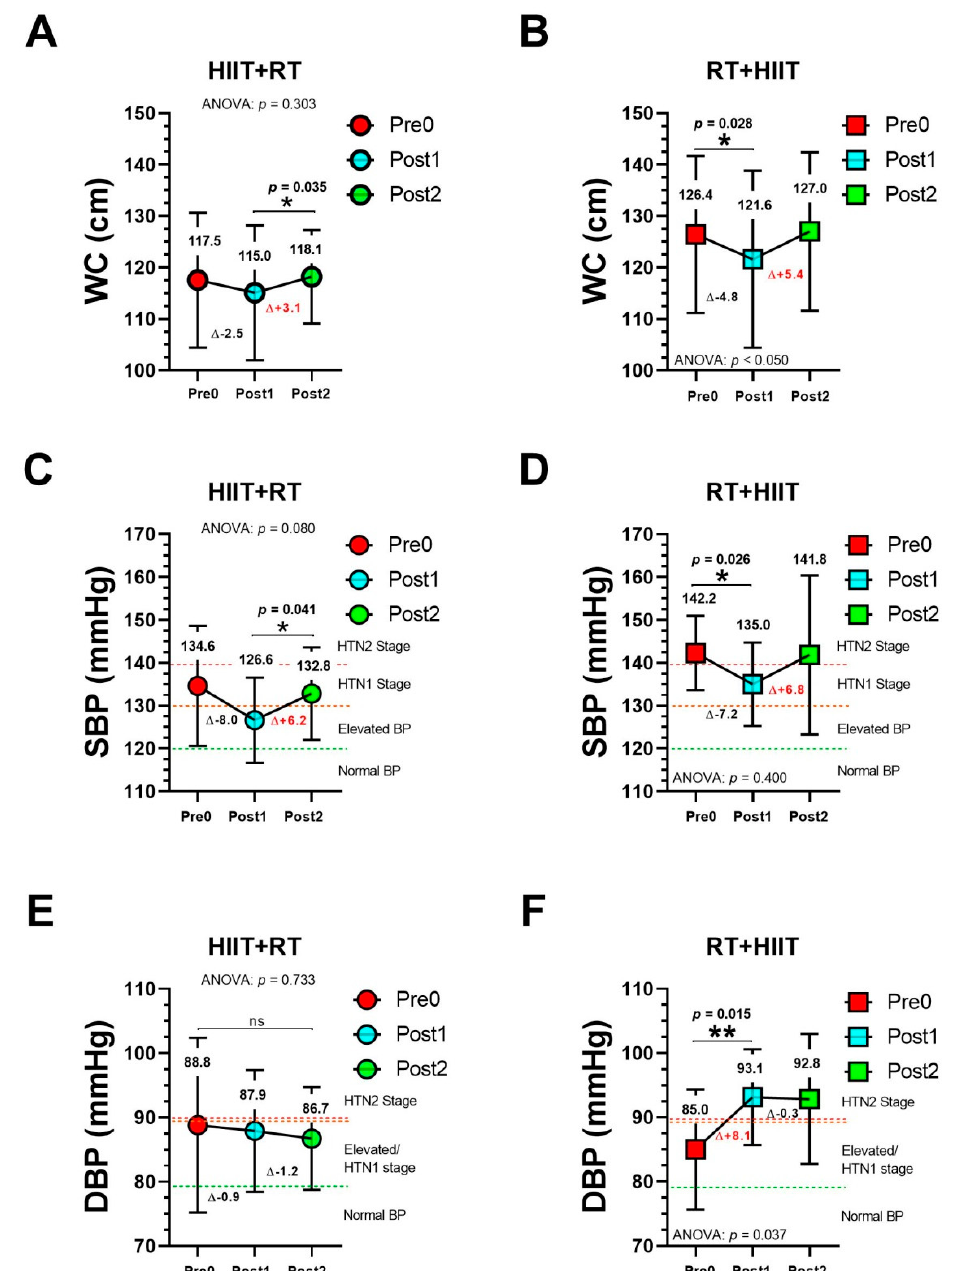
Figure 2. Metabolic syndrome outcomes (WC [panels A , B ], SBP [panels C , D ]/DBP [panels E , F ]) after 20 weeks of different CT orders and after 20 months of COVID-19 confinement. (*) Denotes significant differences at level p < 0.05. (**) Denotes significant differences at level p < 0.001. (ns) Non-significant changes.